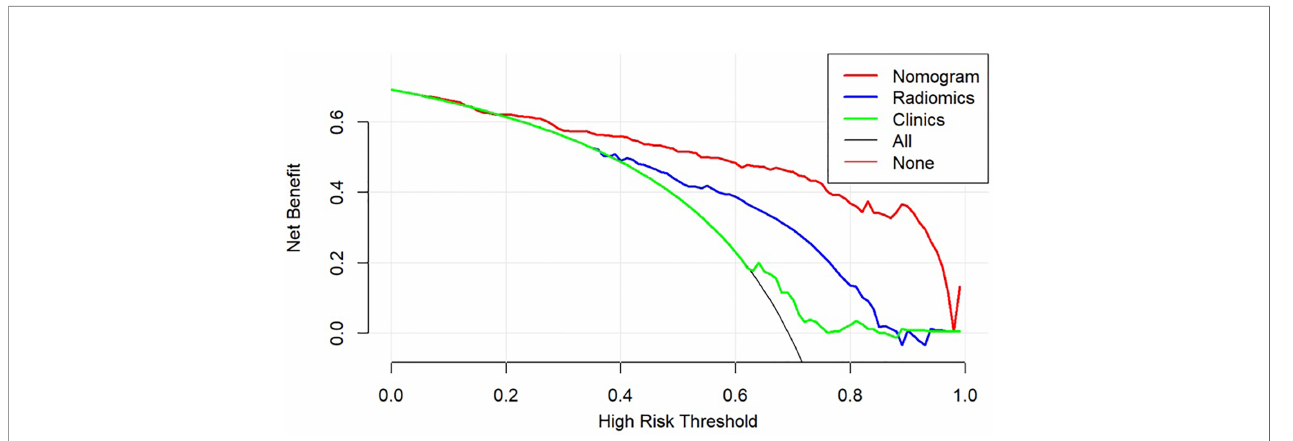
FIGURE 7 | Decision curve analysis for models. The y-axis measures the net bene fi t, which is calculated by summing the bene fi ts (true-positive fi ndings) and subtracting the harms (false-positive fi ndings), weighting the latter by a factor related to the relative harm of undetected GC-PM(+) compared with the harm of being mistaken for